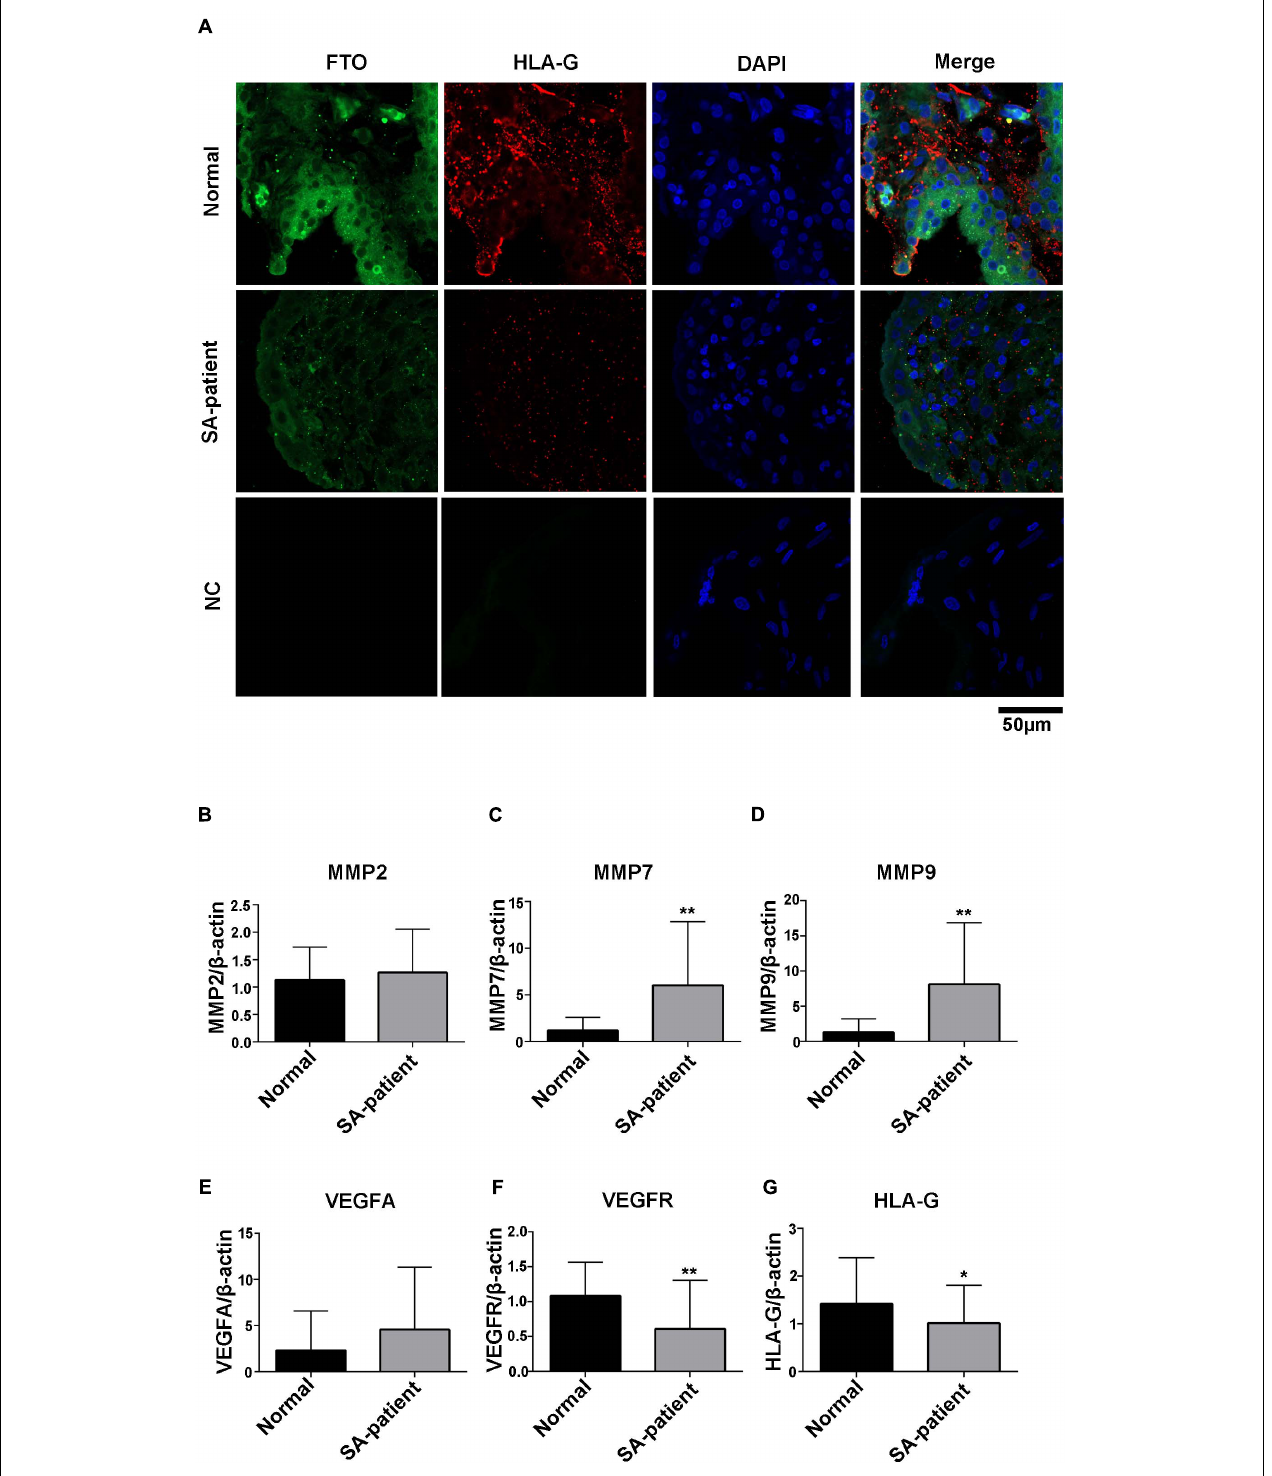
FIGURE 5 | (A) Representative immunofluorescence images of chorionic villi showing in situ expression of FTO and HLA-G in both groups (Normal n = 3; Patient n = 3; NC:negative control n = 3), green – FTO and red – HLA-G. (B) MMP2 , (C) MMP7 , (D) MMP9 , (E) VEGFA , (F) VEGFR , and (G) HLA-G mRNA levels in the indicated groups. (Normal n = 35; Patient n = 49, * P <0.05 and ** P <0.01).